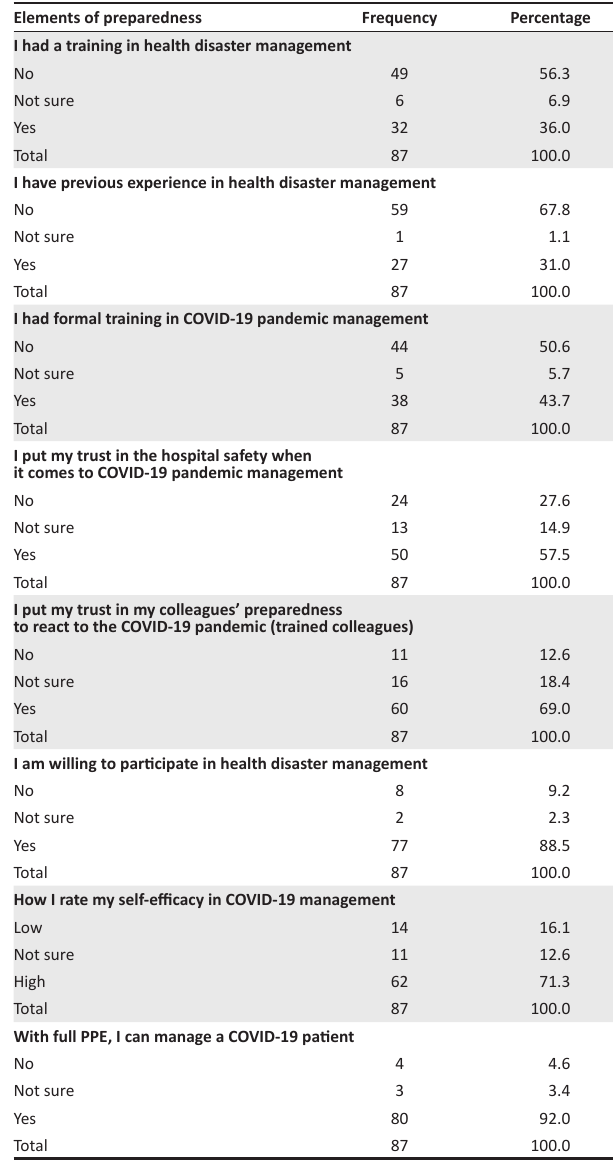
Table 2: Preparedness levels amongst the